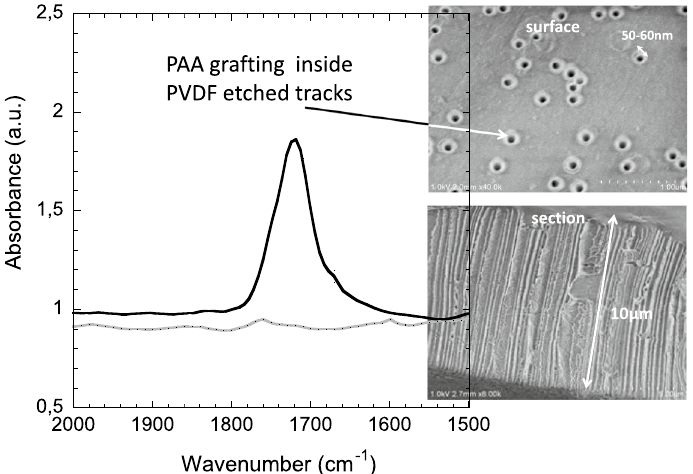
Figure 3. FTIR spectra of track-etched PVDF membrane after 30 min of etching in KOH/KMnO 4 solution at 65 ◦ C (grey curve) and after subsequent radiation-induced grafting in presence of acrylic acid for 1 h at 60 ◦ C and 48 h of Soxhlet purification (black curve)—zoom in the region of carboxylic acids between 2000 cm − 1 1500 cm − —Inset: FESEM images of PAA-g-PVDF track-etched membrane: (top) view of the surface; (down) cryosection.